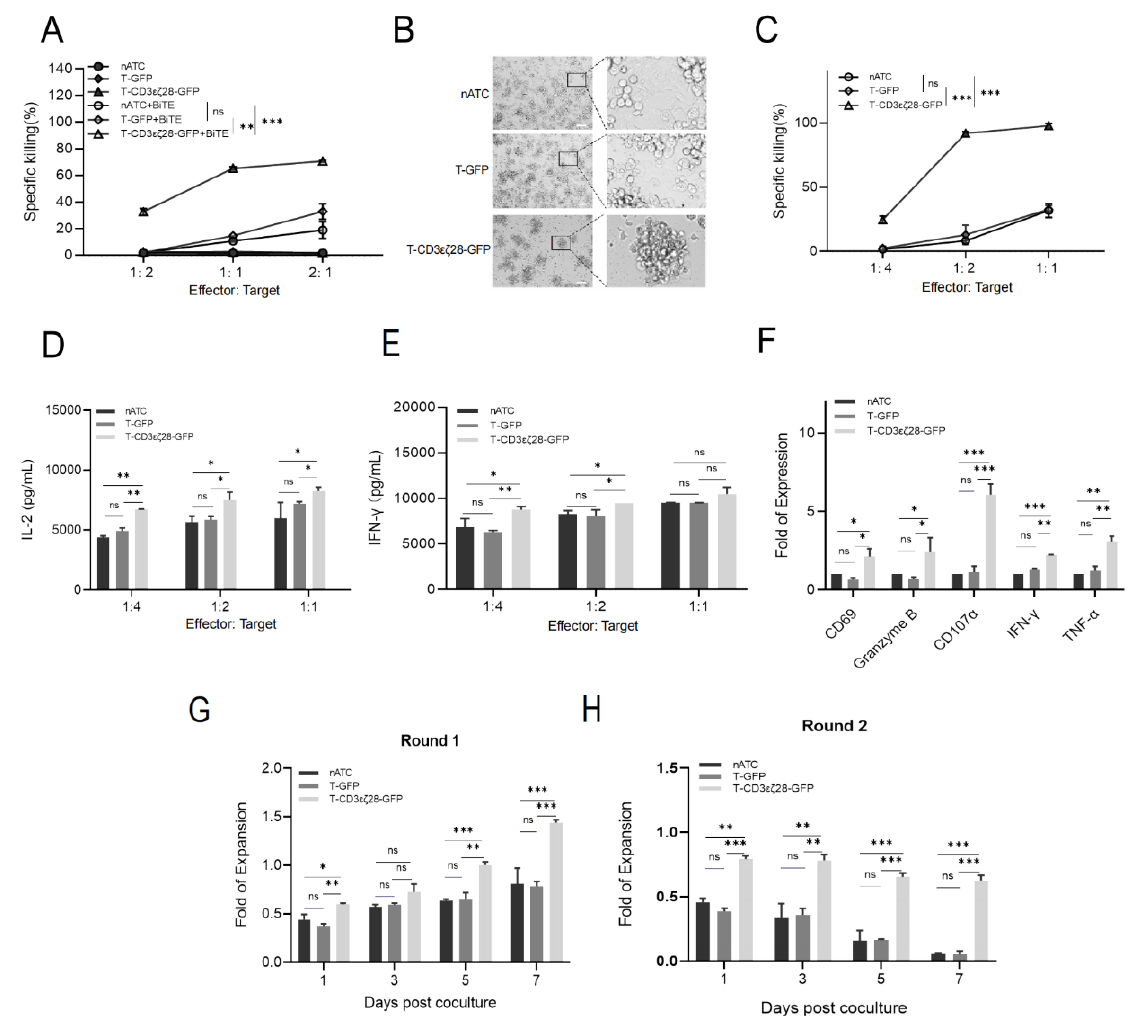
Figure 2. Combination of T-CD3 εζ 28-GFP cells and BiTE exhibited superior capacities of killing cancer cells and persistent proliferation. ( A , B ) Comparison of the cancer cell killing effects of different T cells with or without added BiTE. HeLa cells were co-cultured with nATC or T-GFPor T-CD3 εζ 28-GFP at indicated effector to target (E:T) ratios, with or without EGFRvIII-BiTE for 24 h. The viability of cancer cells was determined by using MTS assays ( A ). The cancer cell killing effects of different T cells with EGFRvIII-BiTE were observed under microscope at E:T ratio of 1:1 ( B ). ( C ) Comparison of the killing effects of different T cells on cancer cells expressing BiTE. Hela cells expressing EGFRvIII BiTE (HeLa-EGFRvIII BiTE) were co-cultured with nATC or T-GFPor T-CD3 εζ 28.-GFP at different E:T ratios for 24 h. The viability of cancer cells was determined by using MTS assays. ( D , E ) Histograms showed the production of cytokines in different T cells. HeLa-EGFRvIII BiTE cells were co-cultured with nATC or T-GFP or T-CD3 εζ 28-GFP at different E:T ratios for 24 h, and then the supernatants were collected. The concentration of IL-2 ( D ) and IFN- γ ( E ) in supernatants were detected by enzyme-linked immunosorbent assay (ELISA). ( F ) Histograms showed the expression levels of genes related to T cell activation. HeLa-EGFRvIII BiTE cells were co-cultured with nATC or T-GFPor T- CD3εζ28 -GFP at different E:T ratios for 24 h, and then the T cells were collected. The relative expression of CD69, GranzymeB, CD107α, IFNγ and TNFα and housekeeping gene GAPDH was evaluated by RT-qPCR assay. The fold change of each gene was calculated using the formula. ( G ) and ( H ) Histograms showed the expansion of T cell during se- quential stimulated by cancer cells. The different T cells were repeatedly stimulated with HeLa- EGFRvIII BiTE cells at an E:T ratio of 5:1 for 24 h. Then T cells were harvested and cultured in fresh medium for 7 days. On the day8, the cultured different T cells were repeatedly stimulated with HeLa-EGFRvIII BiTE cells at an E:T ratio of 5:1 for 24 h. Then T cells were harvested and cultured in fresh medium for another 7 days. The cell numbers of T cells were counted on day 1, 3, 5 and 7 during first 7-day round ( G ) and second 7 day round ( H ), respectively. Statistical differences were assessed by mutual comparison between each two groups using multiple comparisons t test. (* p < 0.05, ** p < 0.01, *** p < 0.001).